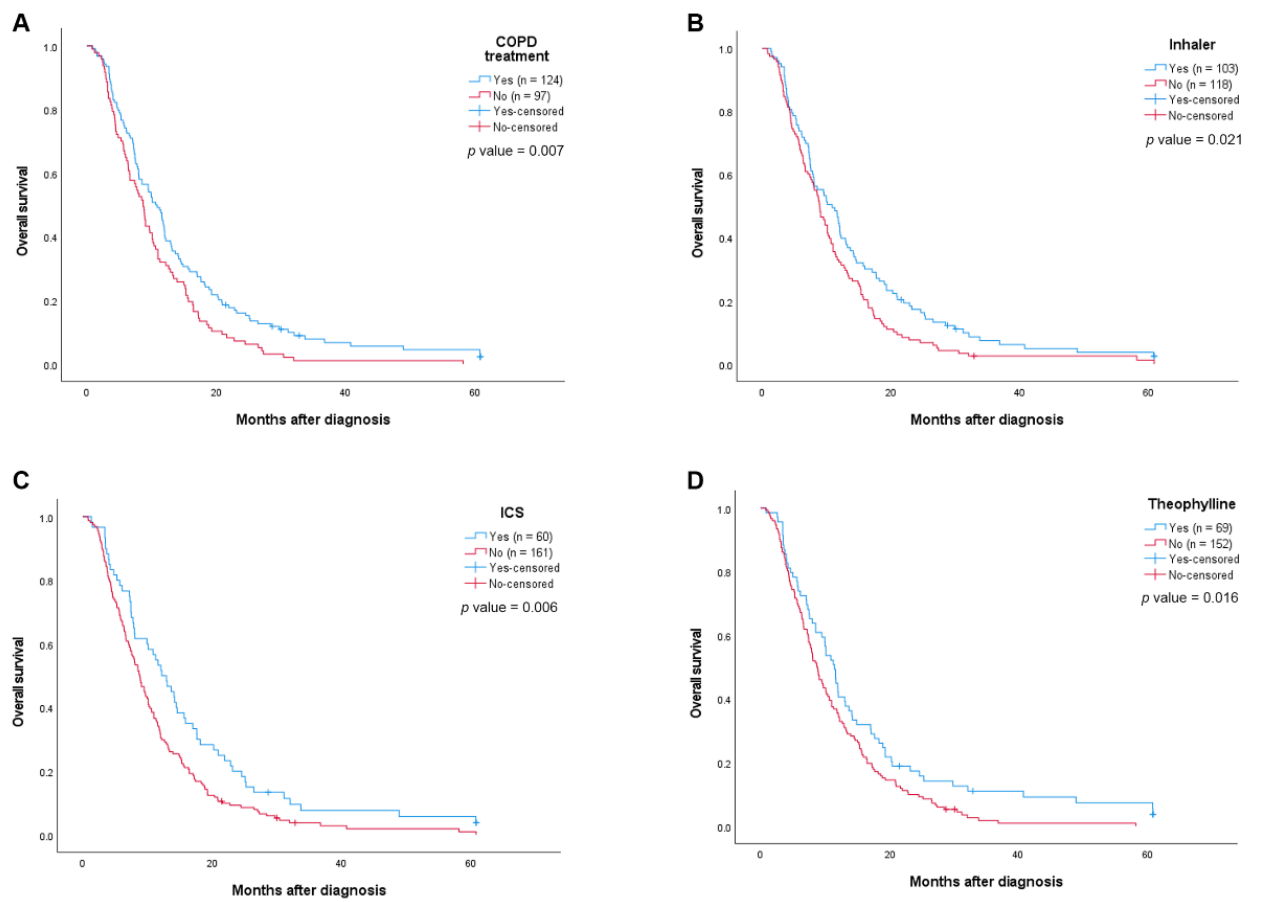
Figure 2. Kaplan – Meier curves of overall survival of advanced NCSLC: ( A ) Overall survival curves by COPD treatment; ( B ) overall survival curves by use of inhaler; ( C ) overall survival curves by use of ICS; ( D ) overall survival curves by use of theophylline.